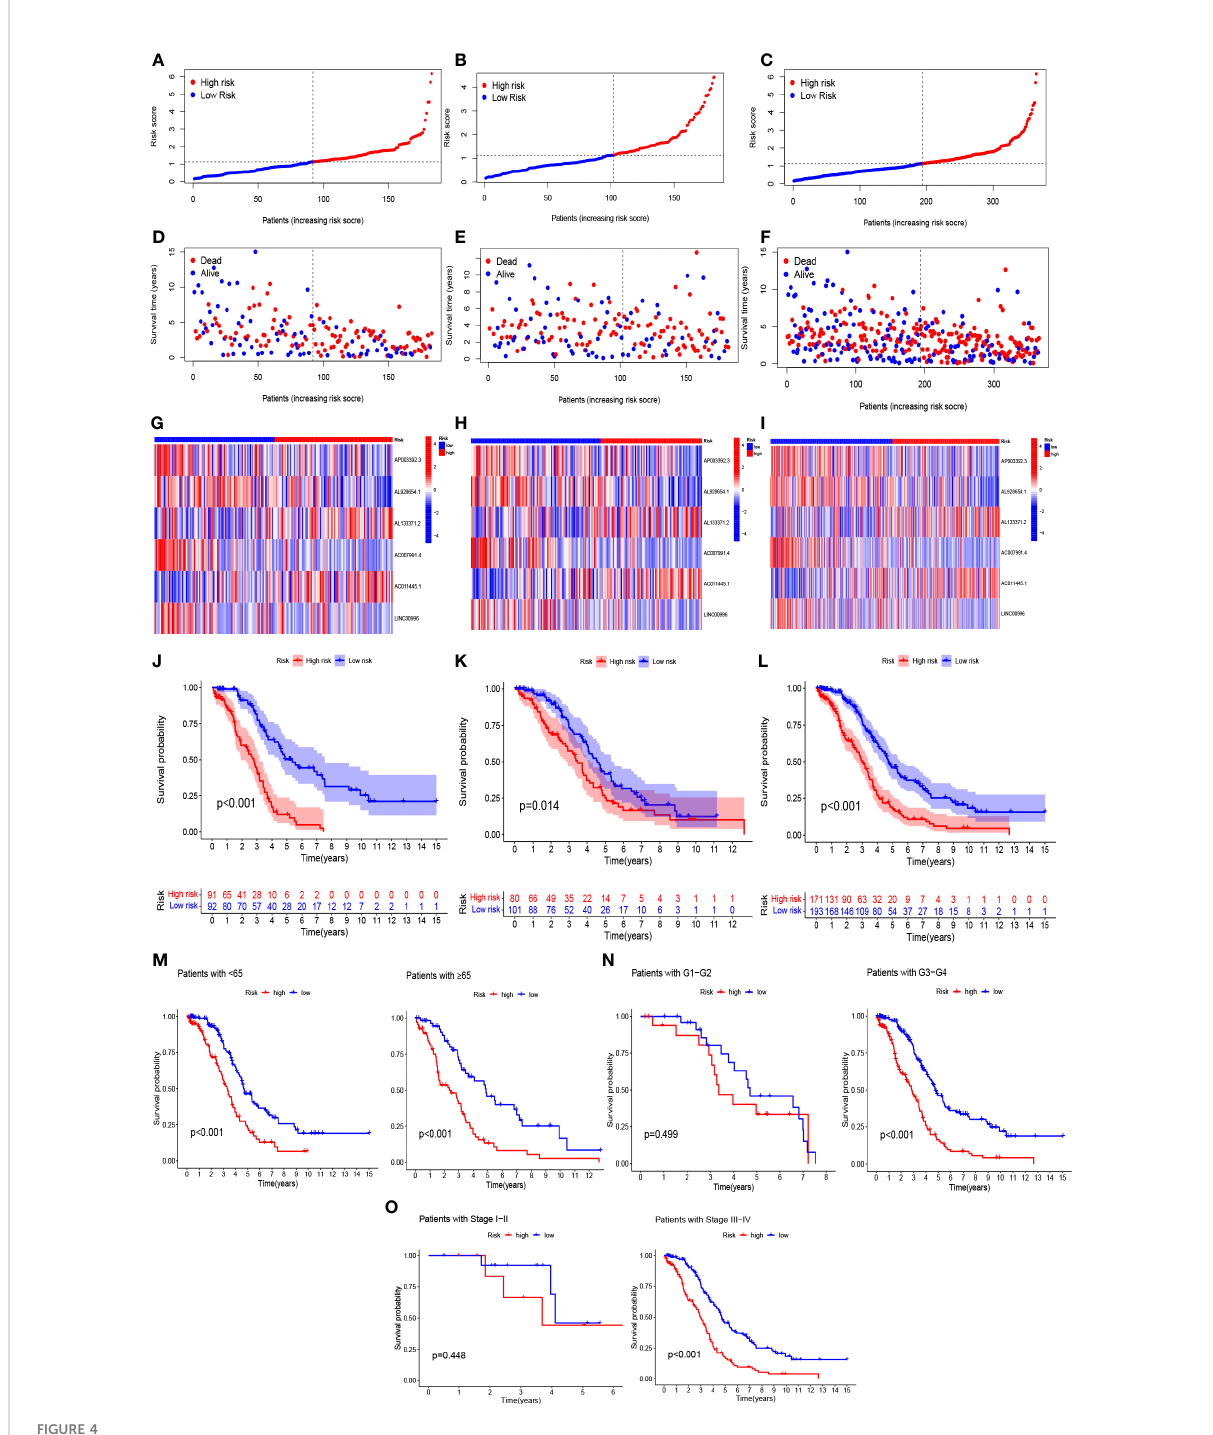
FIGURE 4 In the train, test, and entire sets, the prognostic value of the model for six necroptosis-associated lncRNAs. (A – C) A model of necroptosis- associated lncRNAs according to risk score of the train, test, and entire sets is displayed, respectively. (D – F) Surviving time and survival status among low- and high-risk groups in the train, test, and overall sets. (G – I) The heat maps of 6 lncRNAs expression can be seen in the train, test, and overall set. (J – L) Overall survival of OC patients in the train, test, and entire sets between low- and high-risk groups, respectively (M – O) Survival curves of Kaplan – Meier of OS prognostic value based on age, grade, and stage between low- and high-risk groups in the entire